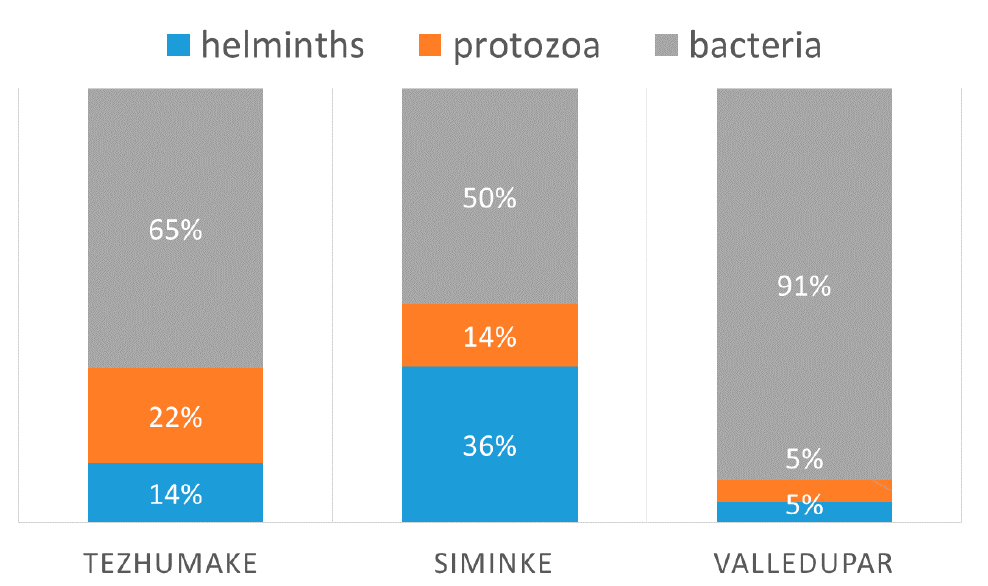
Figure 4. Comparison of infections related to villages.